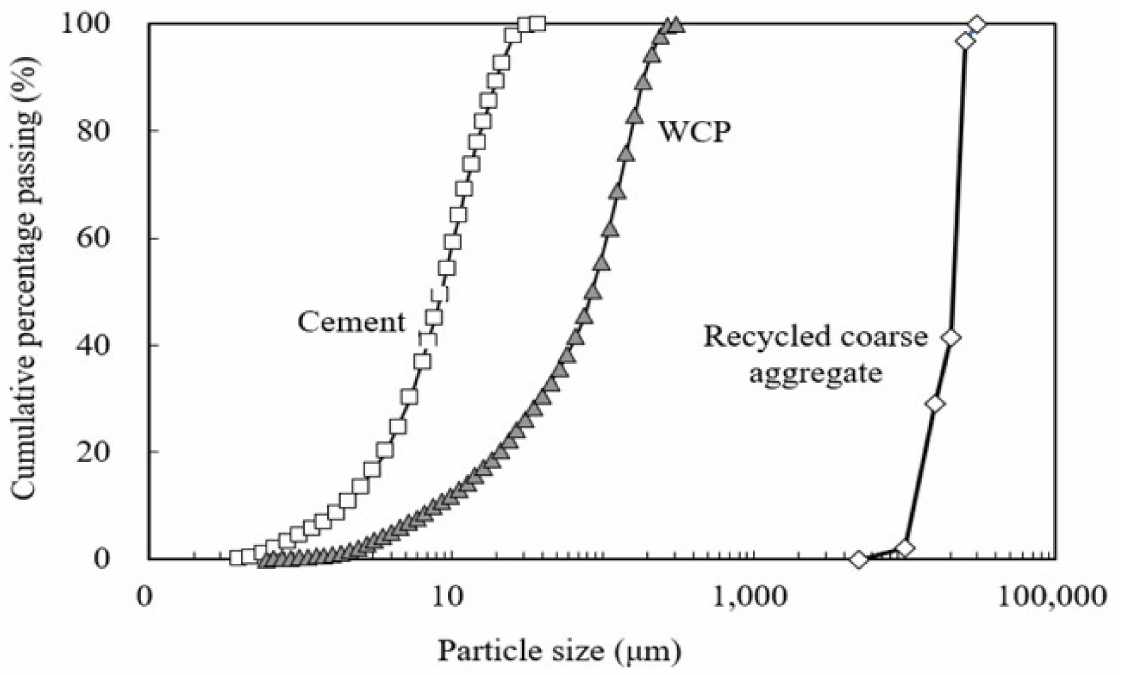
Figure 3. Particle size distributions of cement, WCP and recycled coarse